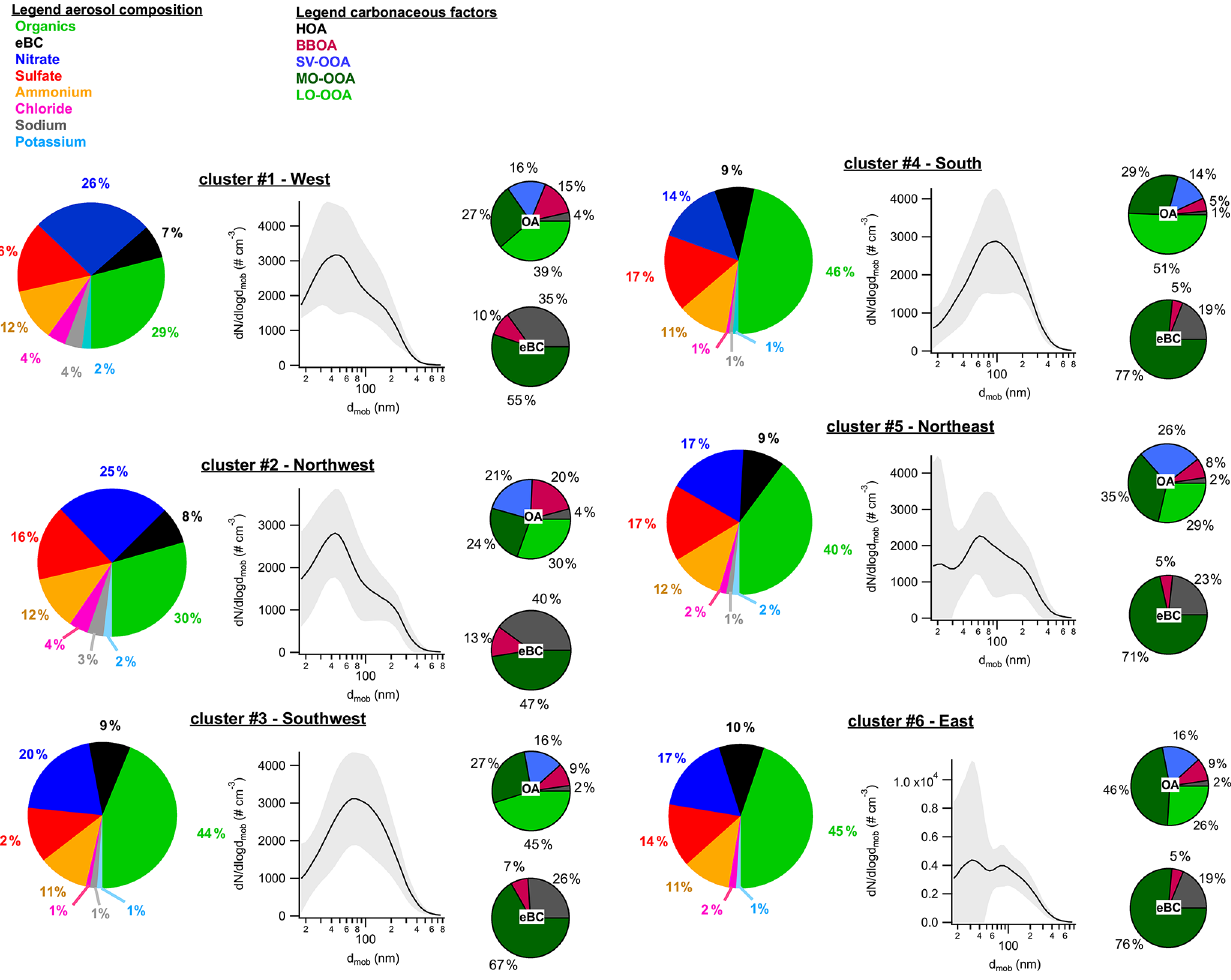
Figure 10. Overview of the chemical composition and the PNSD for each cluster (1–6). The left column shows the mean estimated PM 10 aerosol particle chemical composition. The middle column shows the averaged particle number size distribution ( ± standard deviation in gray). The right column shows the source apportionment results for organic aerosol (top graph) and eBC (bottom